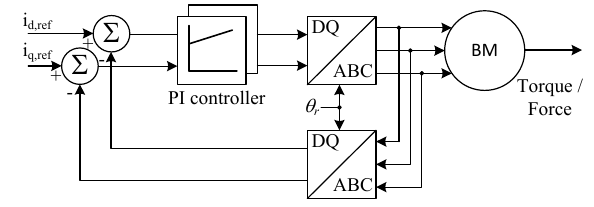
Figure 3: Block diagram of the PI current controller scheme applied to motor drives that produce the radial force. ABC: three-phase reference frame and DQ: rotor reference